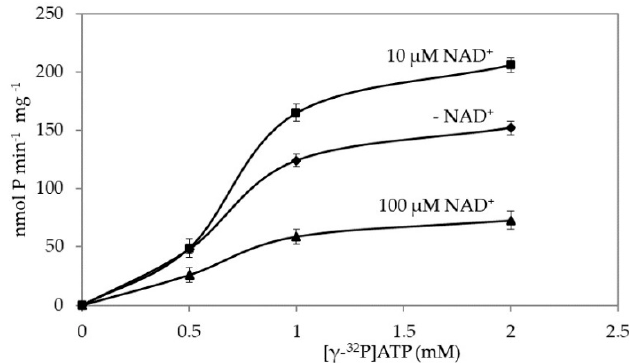
Figure 3. ATPase kinetic of PARPSso. Assays are described in § 2.6. NAD + added at different concentrations ( μ M: 0, ♦ ; 10, ■ ; 100 μ M, ▲ ). The basic kinetic curve ( ♦ ) is the one described in Figure S2.